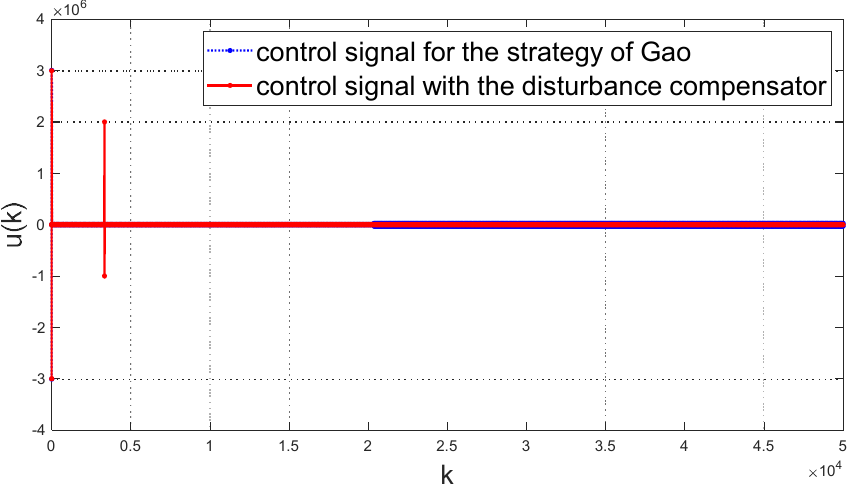
Figure 3. Comparison of the discrete-time sliding variables in the sliding phase.